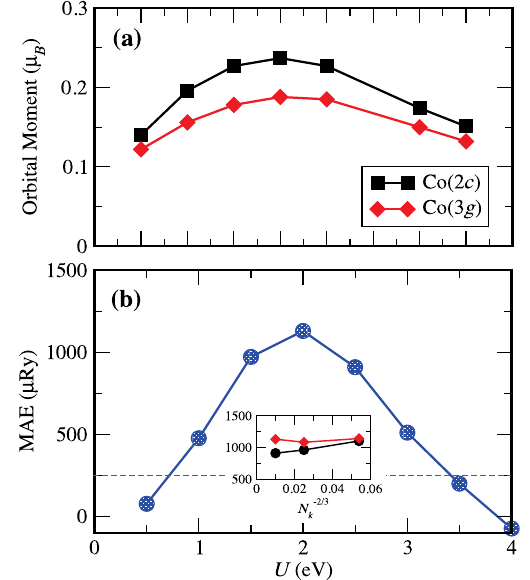
FIG. 3. On-site Coulomb U dependence of the orbital magnetic moments on Co sites and magnetocrystalline anisotropy energy (MAE) per formula unit of YCo 5 . All of the solid curves correspond to the results obtained with the LDA þ DMFT method described in the text. The dashed line corresponds to the measured valued according to Ref. [37]. The inset of (b) shows the MAE dependence on the number of k points in the Brillouin zone for two representative values of Hubbard interaction U ¼ 2 . 0 eV (red line with diamond symbols) and 2.5 eV (black line with circle symbols). The k -point convergence is reasonably Fig. 3(b) ( V ¼ 0 . 84 × 10 − 22 cm 3 is the volume of the primitive unit cell and K 1 ¼ 2 . 98 × 10 18 Ry = cm 3 [37]).